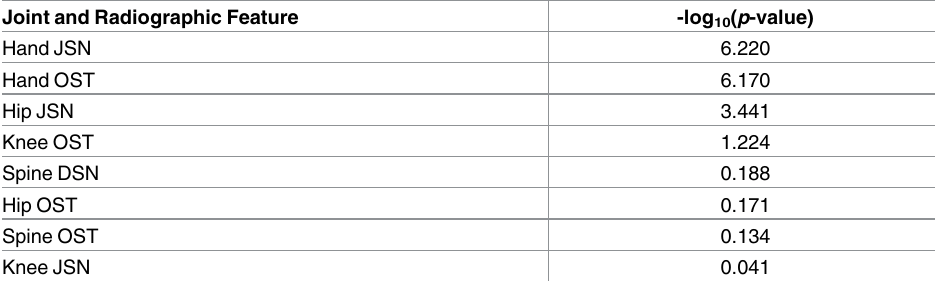
Table 4. Ranking of the effect of joint and radiographic featuresin multivariable